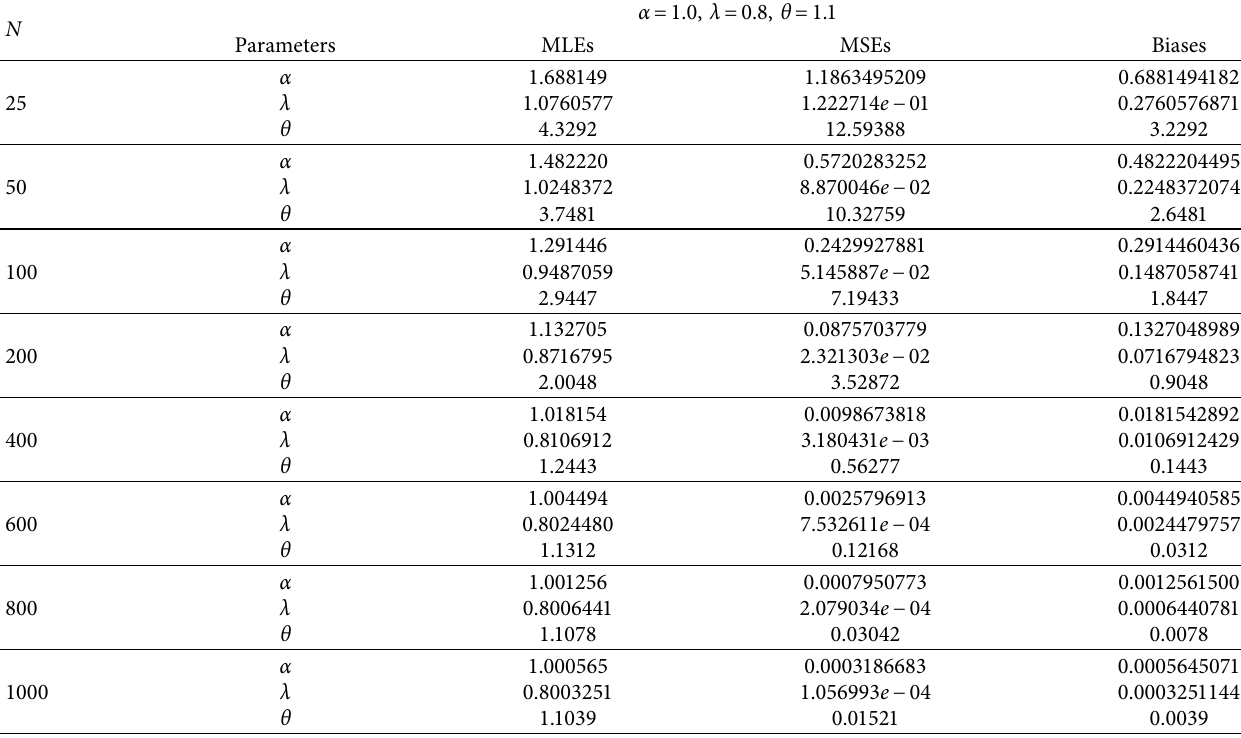
Table 1: The numerical results of the set-1 simulation study for the NEE-W model. N